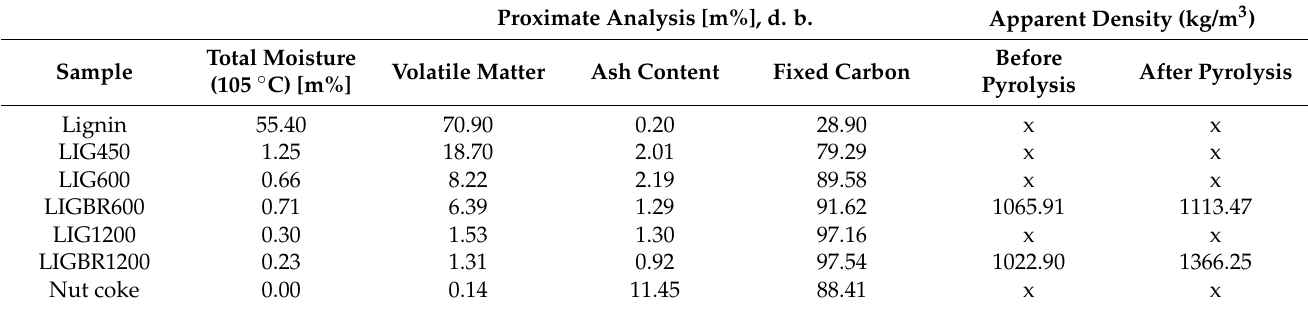
Table 2. Proximate analysis of lignin chars and nut coke. d. b.: dry basis. Proximate Analysis [m%], d. b.